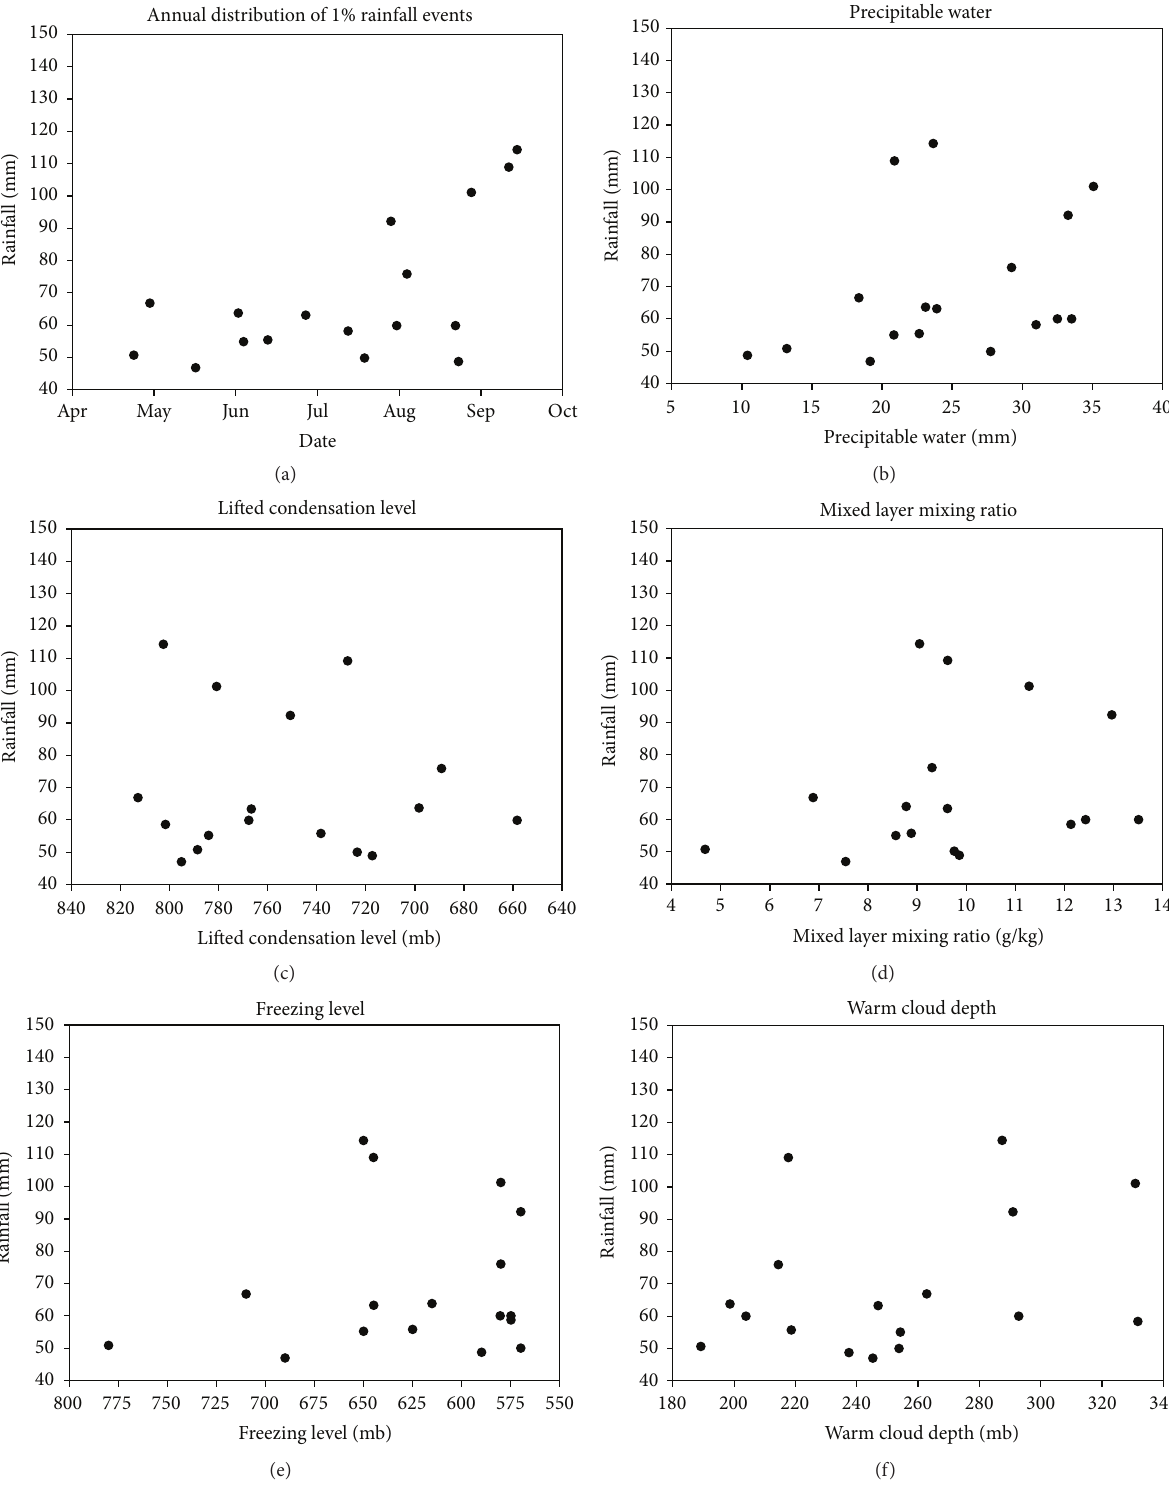
Figure 6: Colorado Springs graphs. (a) Annual distribution of 1% cases. (b) Magnitude of rainfall versus PWater. (c) Magnitude of rainfall versus LCL height. (d) Magnitude of rainfall versus MLMR. (e) Magnitude of rainfall versus freezing level. (f) Magnitude of rainfall versus